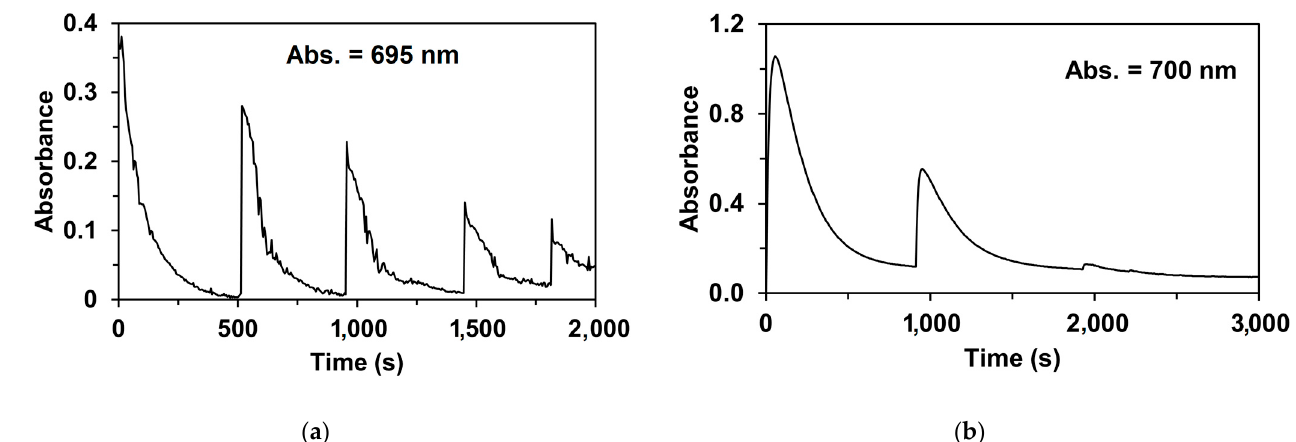
Figure 5. Time course of the formation and decay of µ -1,2-peroxo-diiron(III) ( 3 P and 5 P ) complexes. ( a ) Time course of the formation and decay of µ -1,2-peroxo-diiron(III) ( 5 P ) complex generated in the reaction of 5 with 50 equivalents of H 2 O 2 for 5 cycles: [ 5 ] 0 = 1.0 × 10 − 3 M, H 2 O 2 = 5.0 × 10 − 2 M, T = 298 K, l = 1 cm, V = 2 mL MeCN. ( b ) Generation and decay of 3 P for 3 cycles. [ 3 ] 0 = 1.0 × 10 − 3 M, [H 2 O 2 ] = 4.0 × 10 − 3 M (3×), T = 298 K, l = 1 cm, V = 2 mL MeCN.